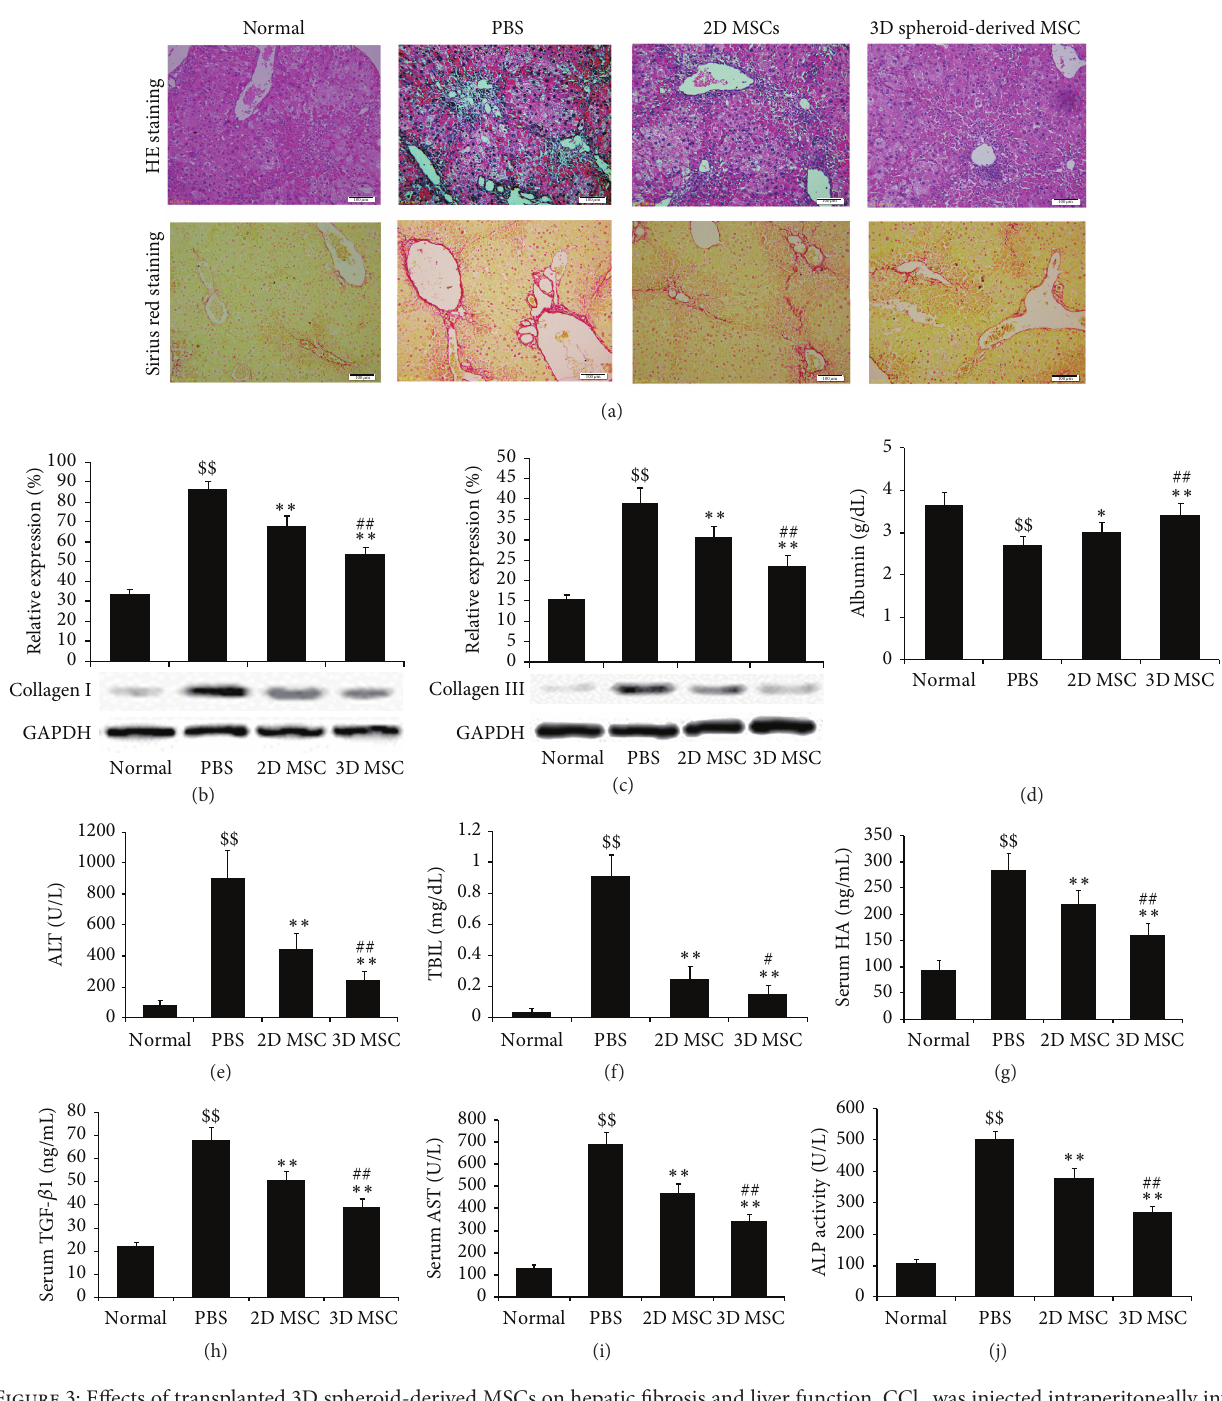
Figure 3: Effects of transplanted 3D spheroid-derived MSCs on hepatic fibrosis and liver function. CCl 4 was injected intraperitoneally into adult female C57BL/6 mice to induce hepatic fibrosis. Then, 500 𝜇 L of PBS, 1 × 10 6 of 2D cultured MSCs, or 1 × 10 6 of 3D spheroid MSCs were injected into the tail vein of hepatic fibrosis model mice. (a) HE and Sirius red staining. Four weeks after MSC transplantation, hepatic tissues were obtained and paraffin-embedded sections were prepared. HE and Sirius red staining were performed to evaluate the hepatic fibrosis (bar = 100 𝜇 m). (b-c) Expression levels of fibrosis-associated factors. Four weeks after MSC transplantation, hepatic tissues were obtained and expression levels of fibrosis-associated factors (Collagen I and Collagen III) were determined by Western blotting. GAPDH was the internal control. (d–j) Analysis of serum markers associated with liver function. Four weeks after MSC transplantation, serum levels of albumin (d), ALT (e), TBIL (f), AST (i) were tested using automatic biochemistry analyzer. Serum HA (g) and TGF- 𝛽 1 (h) levels were determined by ELISA and the double-antibody sandwich chemiluminescence immunoassay, respectively. Serum ALP activity (j) was estimated using commercial kits. $$ 𝑝 < 0.01 compared with normal; ∗ 𝑝 < 0.05 compared with PBS and ∗∗ 𝑝 < 0.01 compared with PBS; # 𝑝 < 0.05 compared with 2D MSC medium and ## 𝑝 < 0.01 compared with 2D MSC